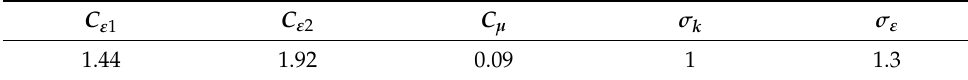
Table 4. Co-efficient values for k - ε turbulence